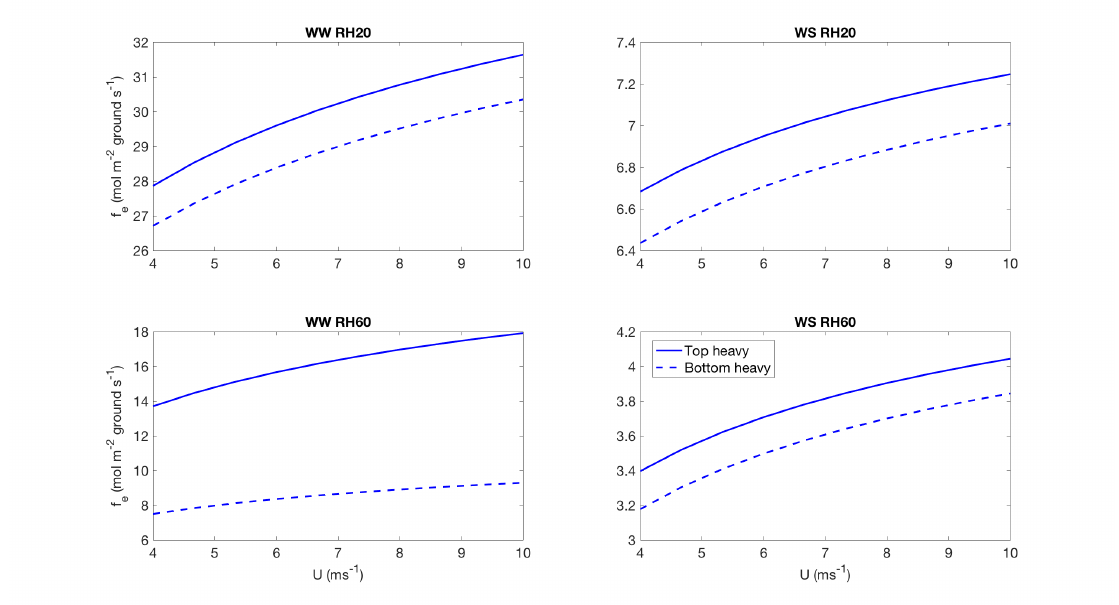
Figure 6. Variation of canopy level transpiration with wind speed for the four scenarios for both top heavy (solid line) and bottom heavy (dashed line) scenarios in low light